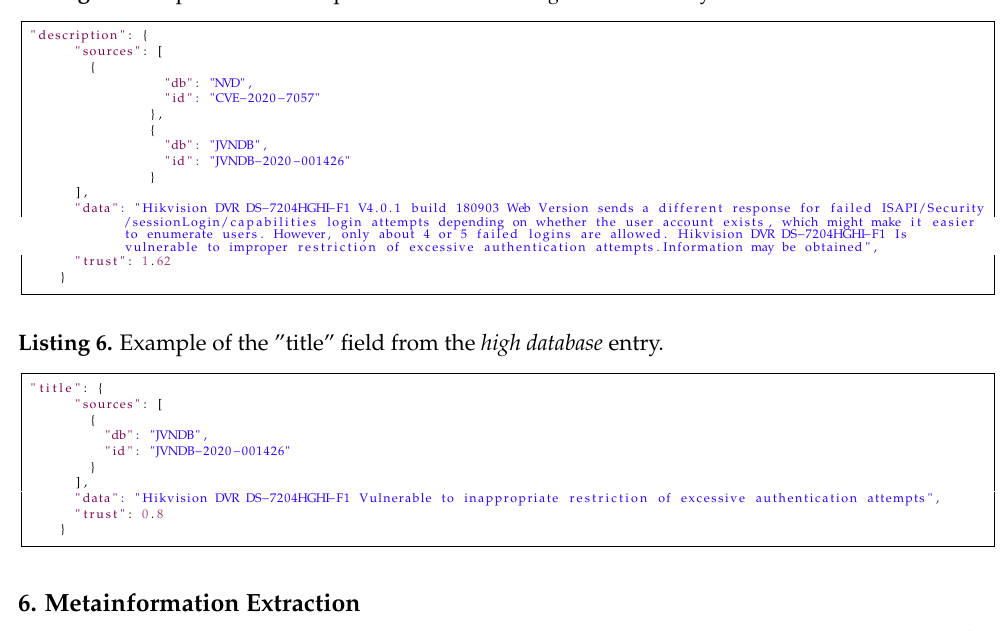
Listing 5. Example of the description field from the high database entry.